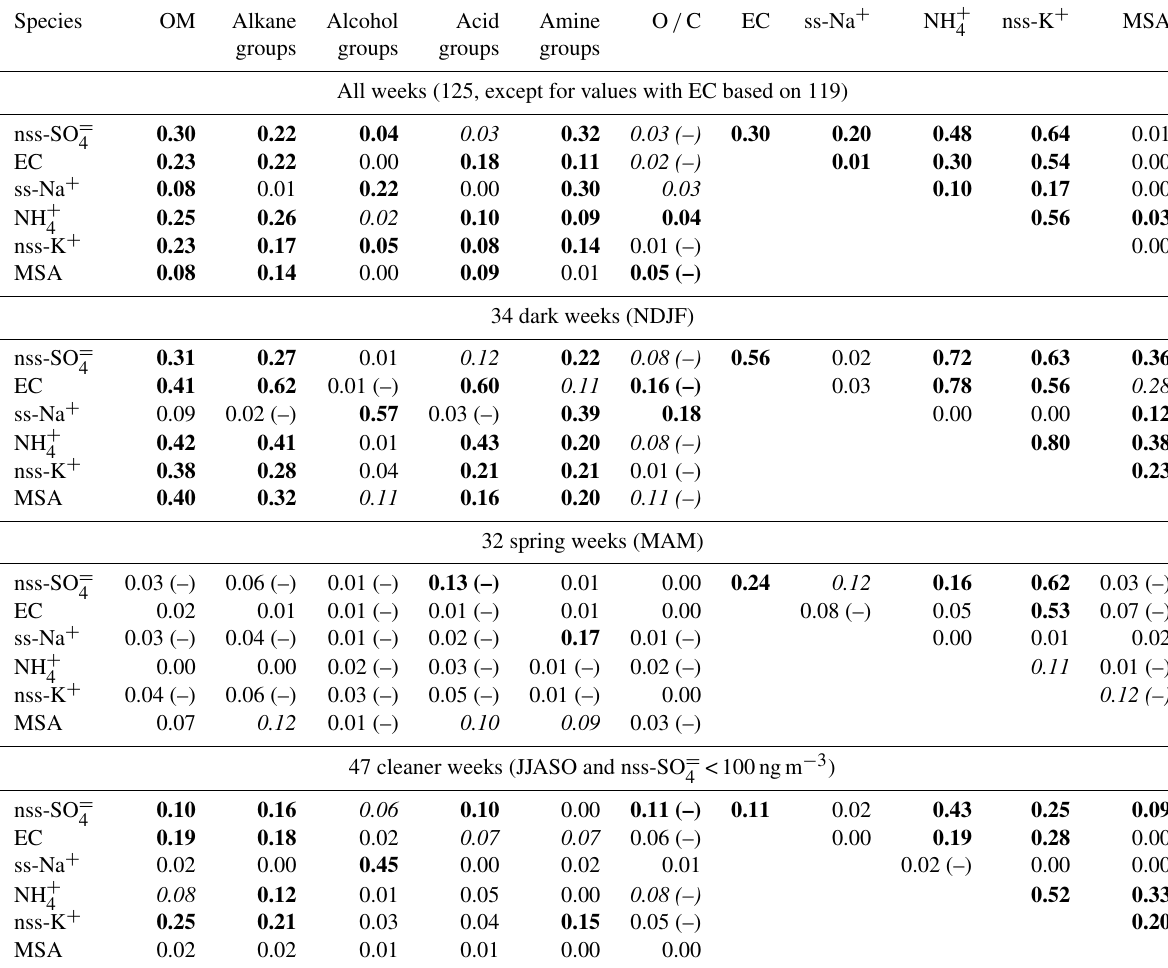
Table 3. Coefficients of determination for linear regressions based on weekly-averaged samples. Values in italic font indicate p of slope is <0.10. Values in bold font indicate p of slope is <0.05. A minus sign in brackets indicates a negative